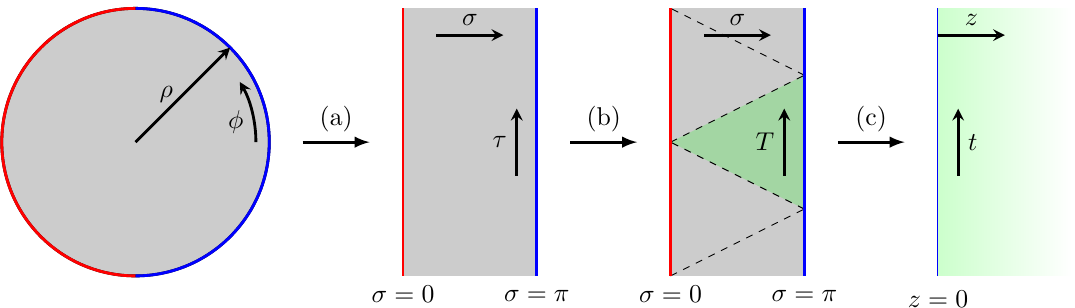
Figure 4. Map from euclidean global AdS 2 (left) to the Poincar(cid:19)e patch (right). a) Transformation from the disk to the strip, implemented by the change of coordinates in equation (5.13). b) Inverse Wick rotation from the euclidean strip to the lorentzian one, implemented by (cid:28) = iT . c) Poincar(cid:19)e patching of the lorentzian strip, implemented by formula